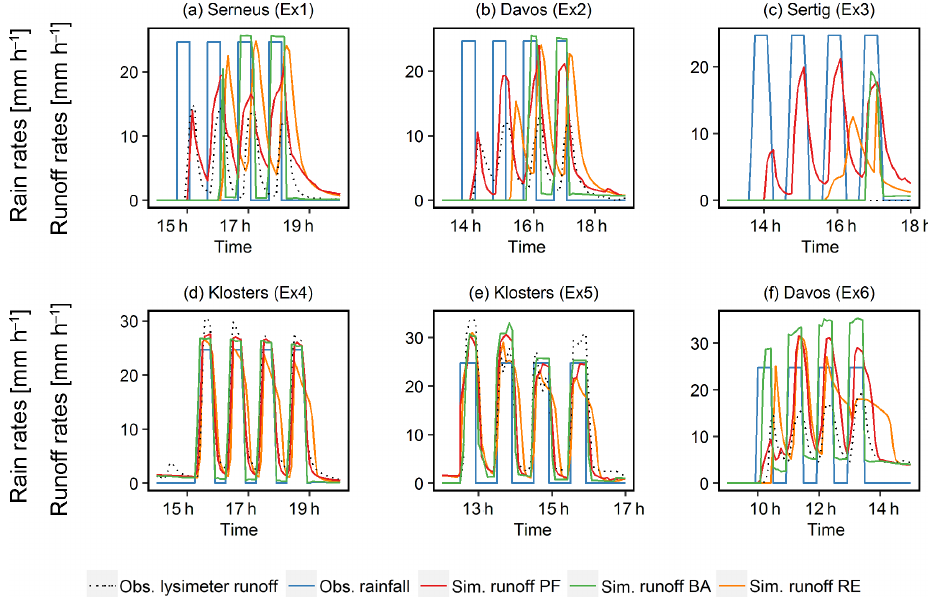
Figure 5. Rain and snowpack runoff displayed as hydrographs for the six sprinkling events. Ex1 (a) –Ex3 (c) were conducted during winter conditions, Ex4 (d) –Ex6 (f) were conducted during spring